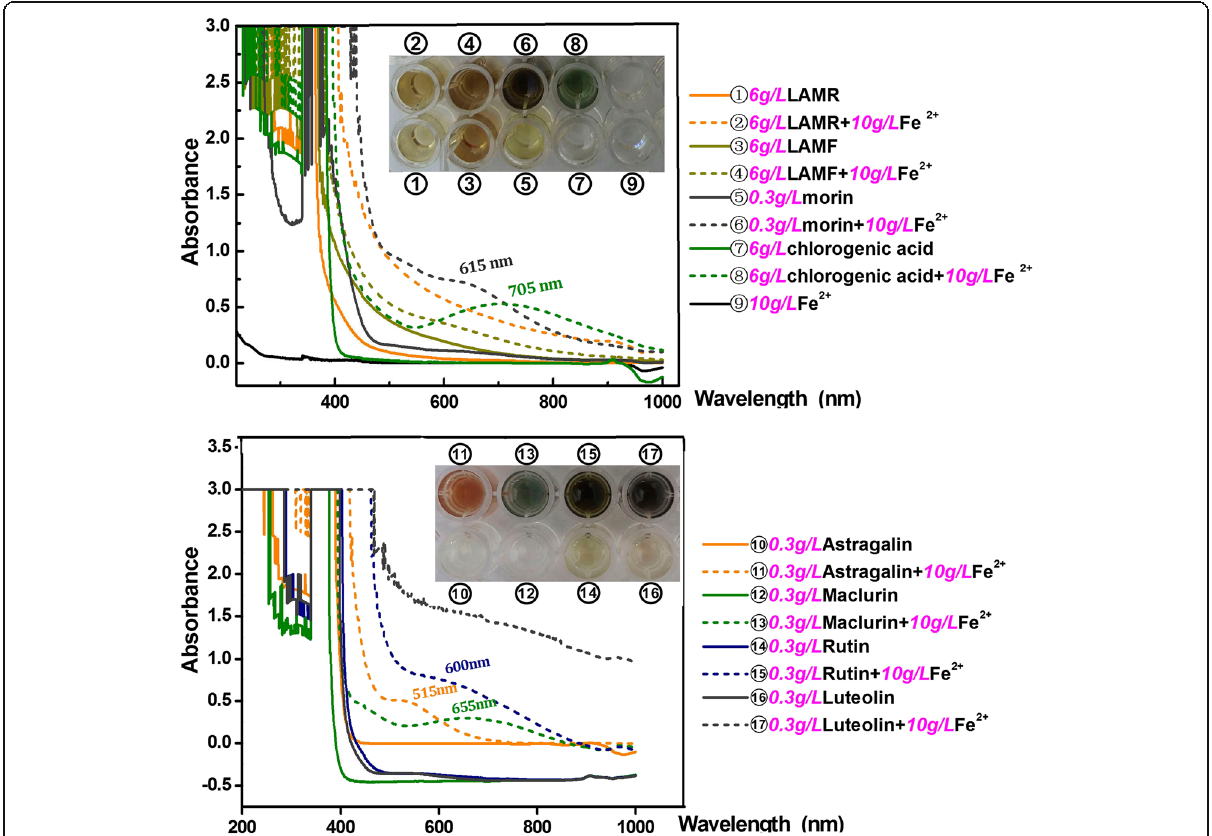
Fig. 5 UV spectra of chelation products of LAMF, LAMR and relevant phytophenols with excess Fe 2+ (The inset figures are the appearances of chelation products. The Fe 2+ -chelating ability of isoquercitrin was reported in our previous paper